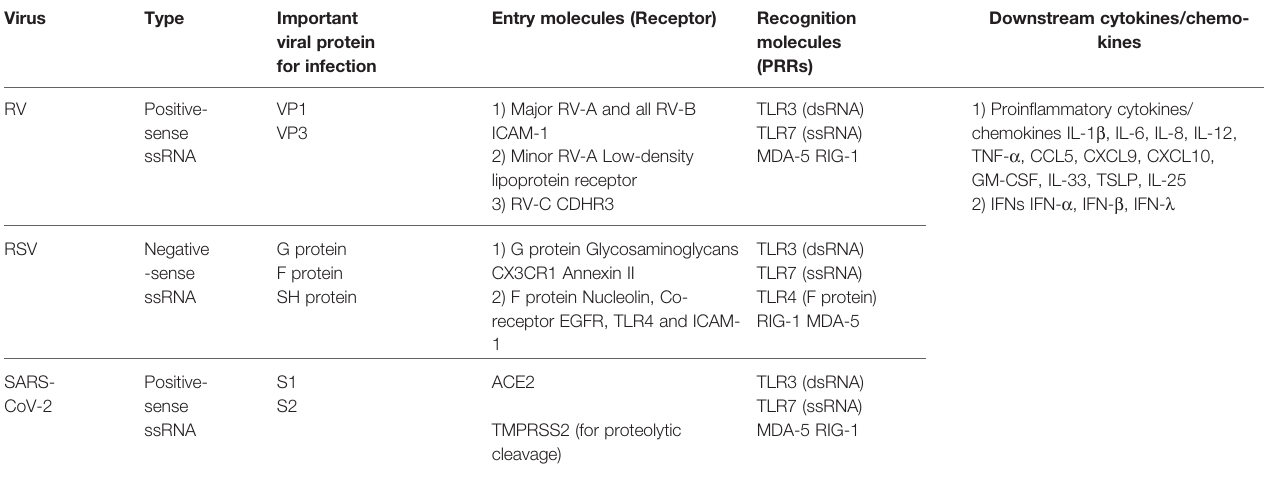
TABLE 1 | Characteristics of virus, important viral protein, entry molecules, recognition molecules and downstream cytokines/chemokines of RV, RSV and SAR-CoV-2.